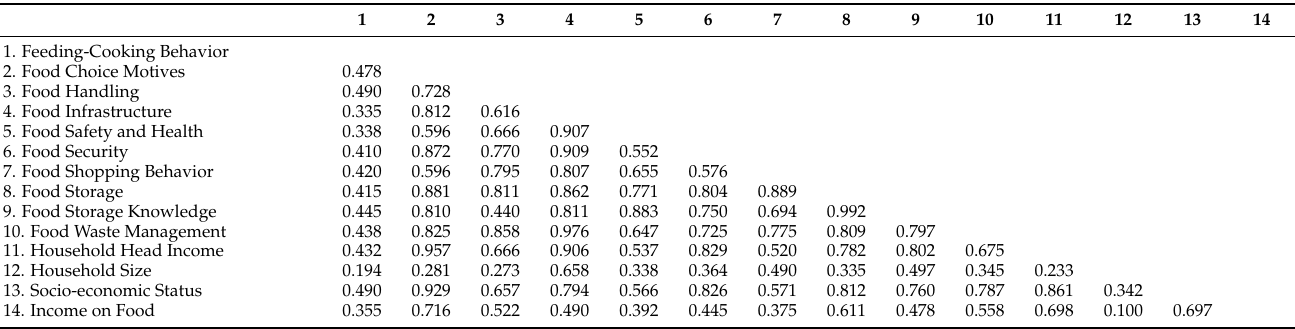
Table 9. Relationship between food storage determinants, practices and outcomes (Heterotrait– Monotriat